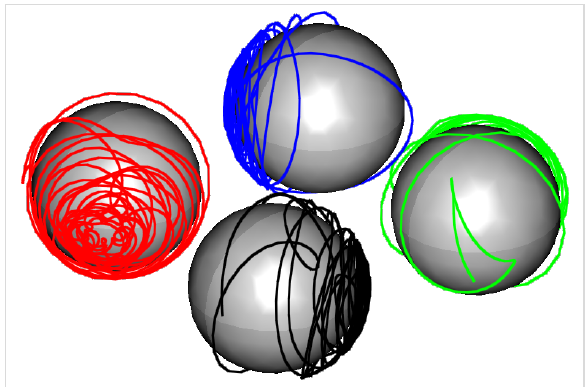
Figure 16: Magnetization evolution of four interacting magnetic dipoles arranged in the corners of a square with side length a = 15 nm. Dipole strengths are chosen equivalent to nanoparticles of radius R = 5 nm and M S = 200 kA/m, the damping constant is set to α = 0.02. The stable equilibrium is reached after a timescale of 100 ns and is compa- rable to a vortex state which entails a very low stray field